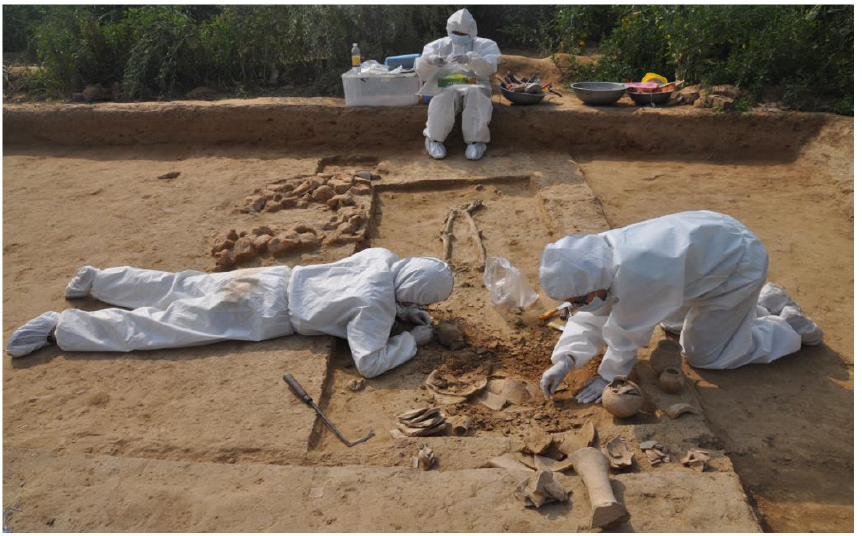
Figure 5. Contamination-avoiding measures taken by the excavators at the Harappan site of Rakhi- garhi.